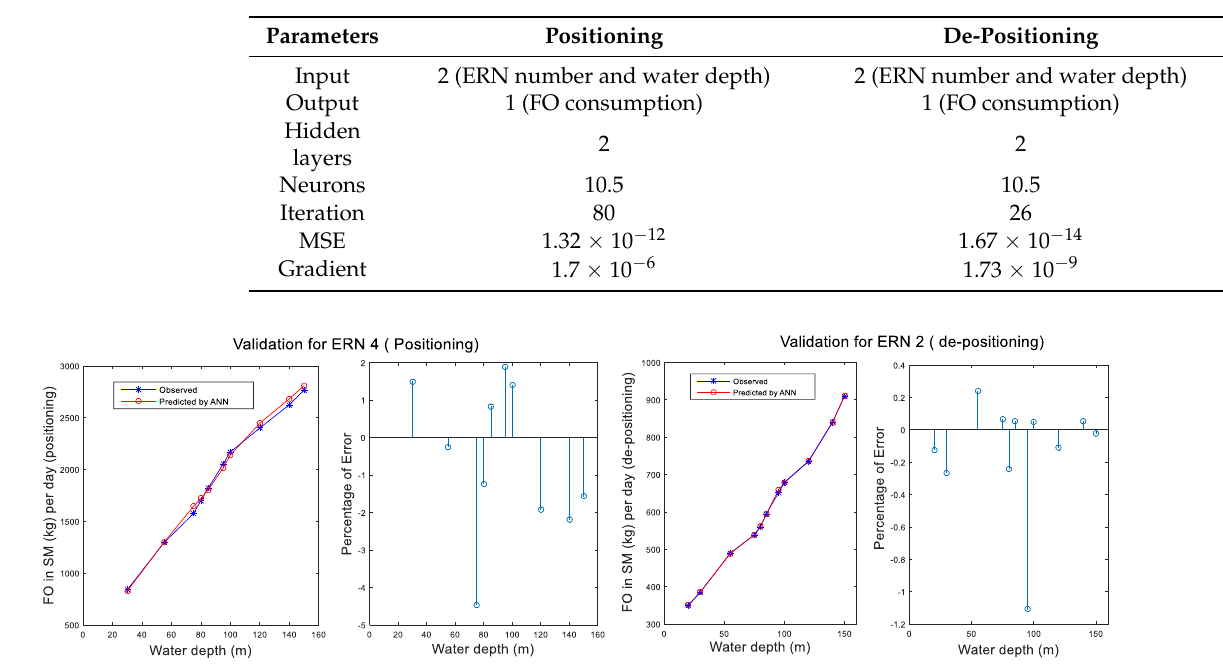
Table 8. Parameters of the trained ANNs for FO consumption prediction in SM system. Parameters Positioning De-Positioning